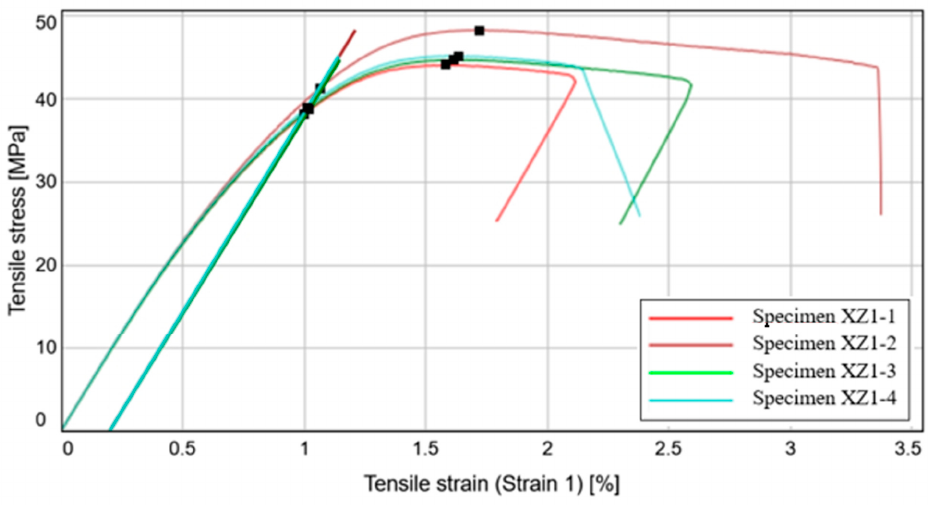
Figure 11. Stress-Strain curve variation for the XZ1 specimens.